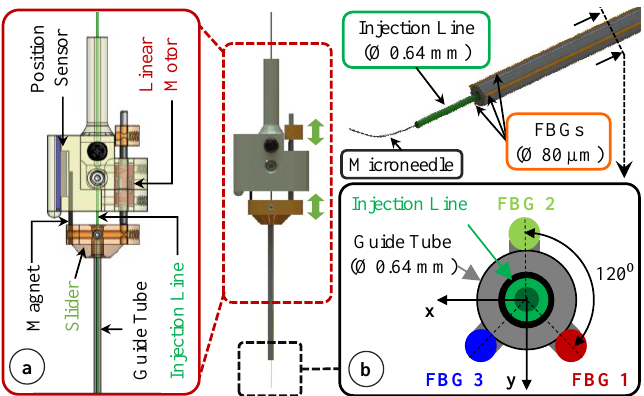
Figure 3. Motorized actuation of the tool for retracting the guide tube back and exposing the prebent microneedle. The inner tube of the tool shaft delivers the injection fluid, while 3 FBG sensors on the outer tube sense transverse forces on the microneedle.